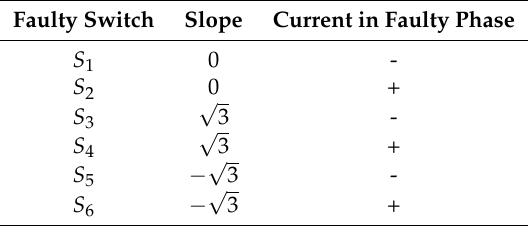
Table 4. Detection of faulty